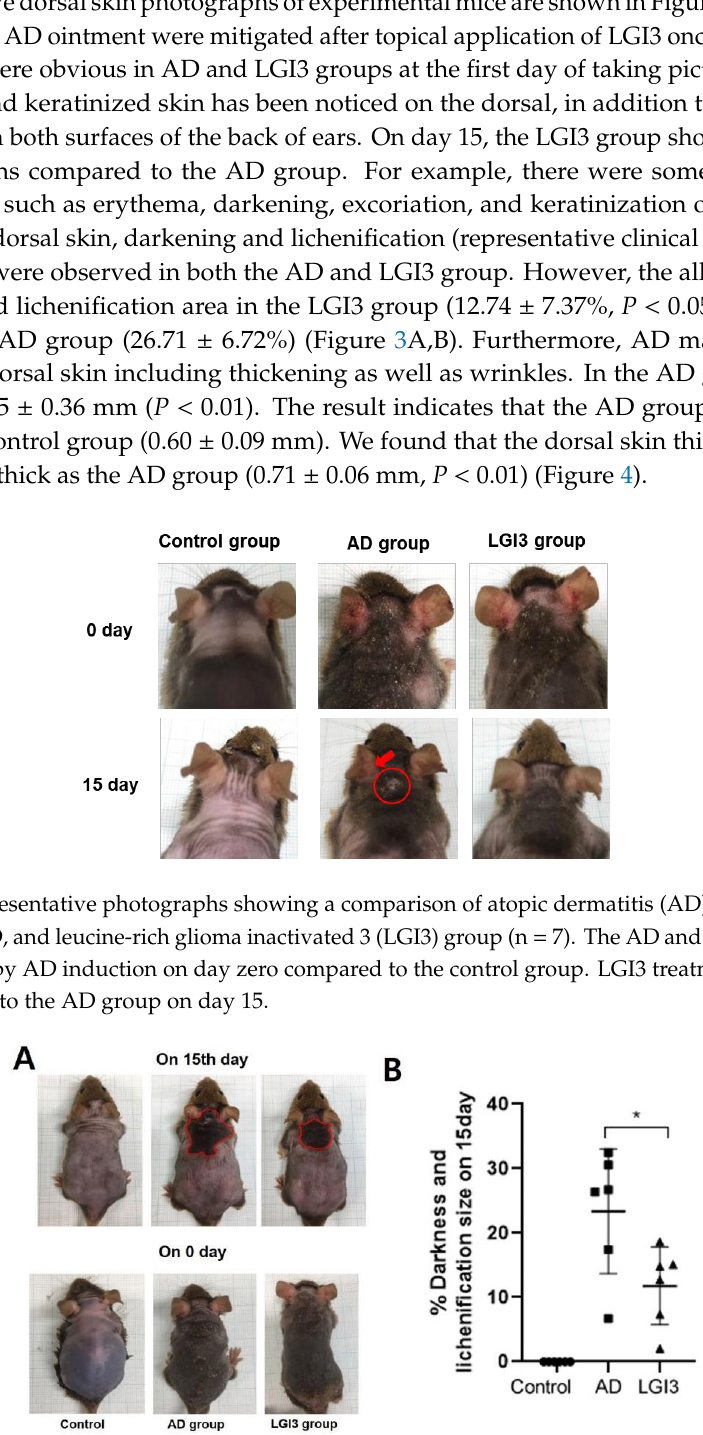
Figure 3. E ff ect of leucine-rich glioma inactivated 3 (LGI3) treatment on % darkness and lichenification area in mice (n = 6). ( A ) Chronic atopic dermatitis (AD) skin lesions area featured with darkness and lichenification. ( B ) Improvement in chronic AD skin lesions in LGI3 compared to AD group ( B ). The alleviating e ff ects on darkening and the lichenification area in LGI3 group were significant compared to the AD group. Data are expressed as mean ± S.D. (* P < 0.05 vs. AD model). Di ff erences between the control and AD model, LGI3 and the AD model group were estimated by